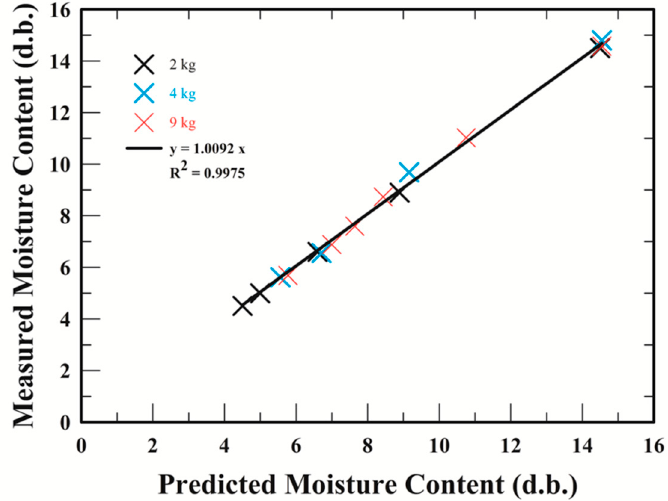
Figure 11. Experimental values of the moisture content versus the predicted values using a simple exponential model for WG drying with different loadings, from 2 to 9 kg, at 120 °C; the lines represent the fitting value.